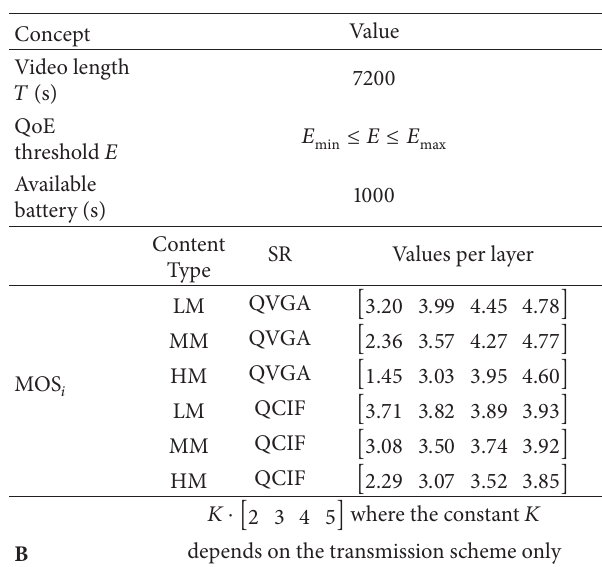
Table 1: Values for coefficients for battery minimizing SOLP ob- tained from [8].